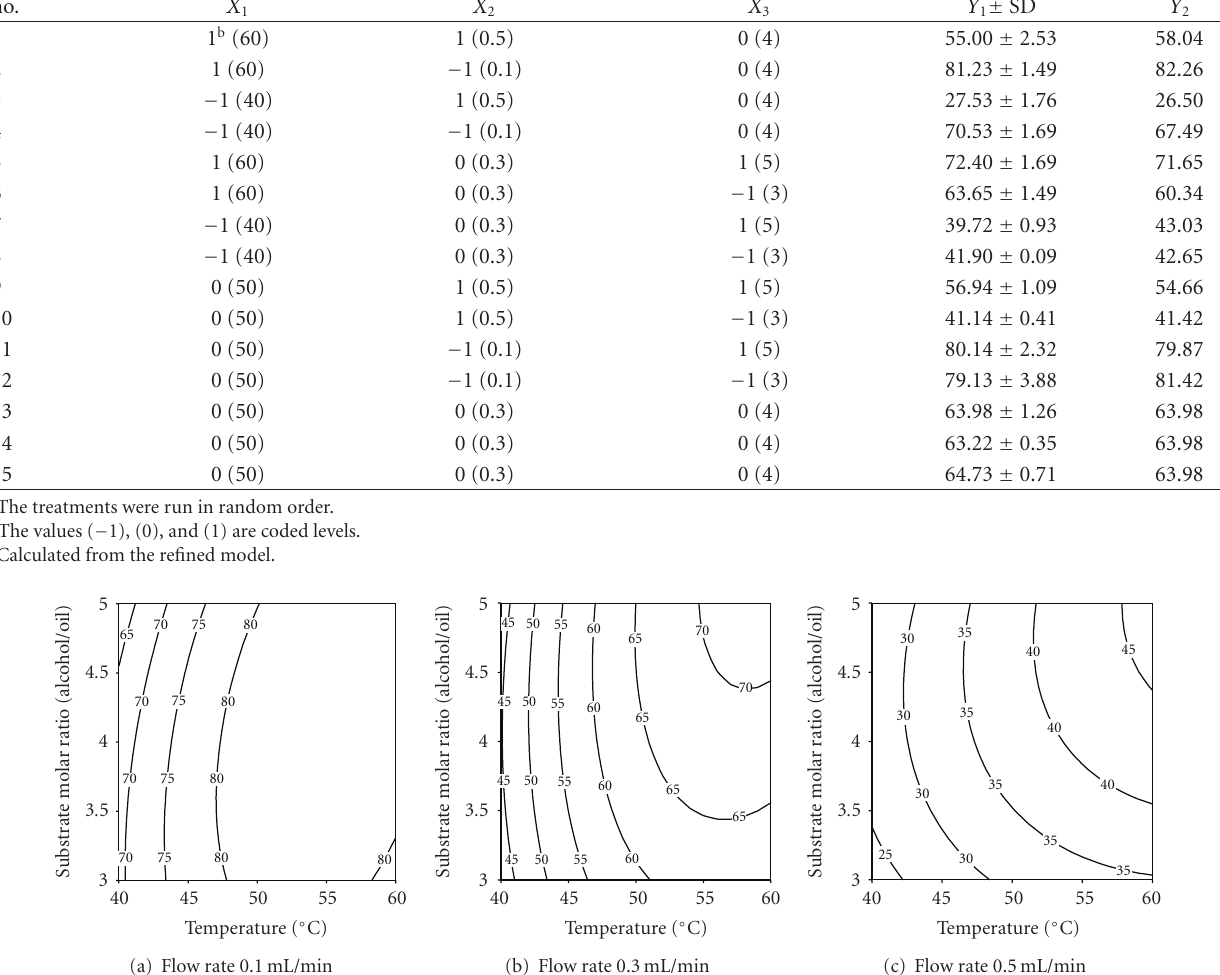
(c) Flow rate 0.5mL/min